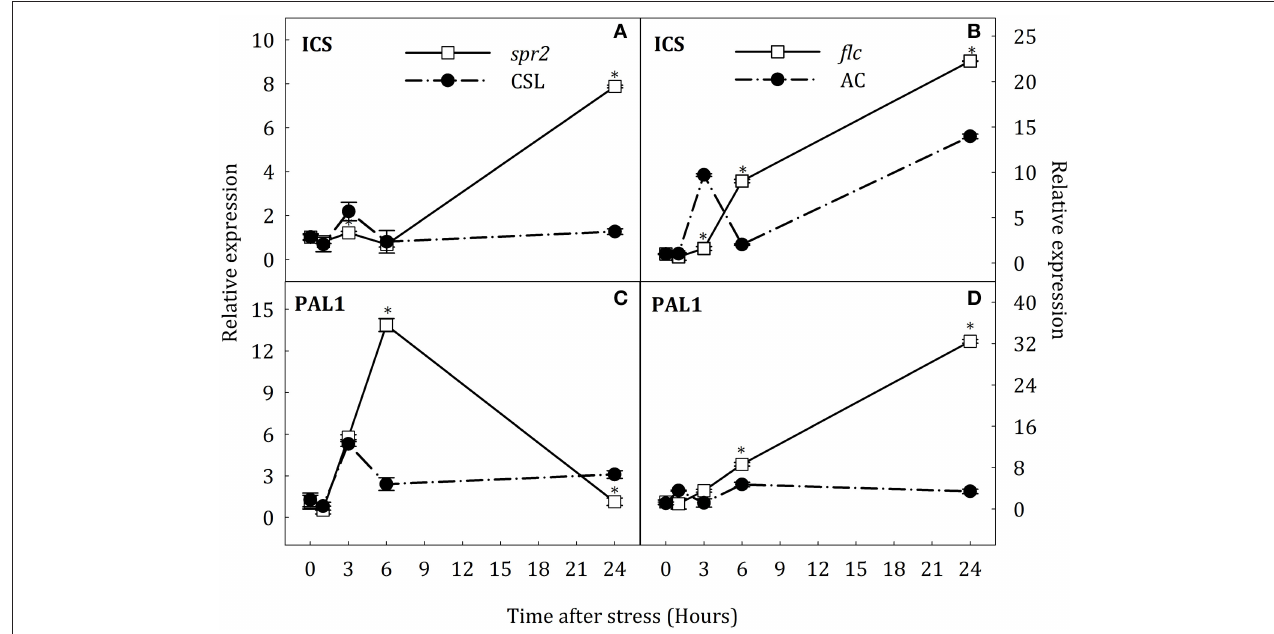
FIGURE 7 | Relative expression of ICS (A,B) and PAL1 (C,D) in roots of Solanum lycopersicum [WT (CSL and AC, black circles) and mutants ( spr2 and flc , white square)] under control ( t = 0 ) and water-stress conditions. Data are mean values ± standard deviation of three independent determinations. Asterisks denote statistical difference with respect to WT at p ≤ 0.05